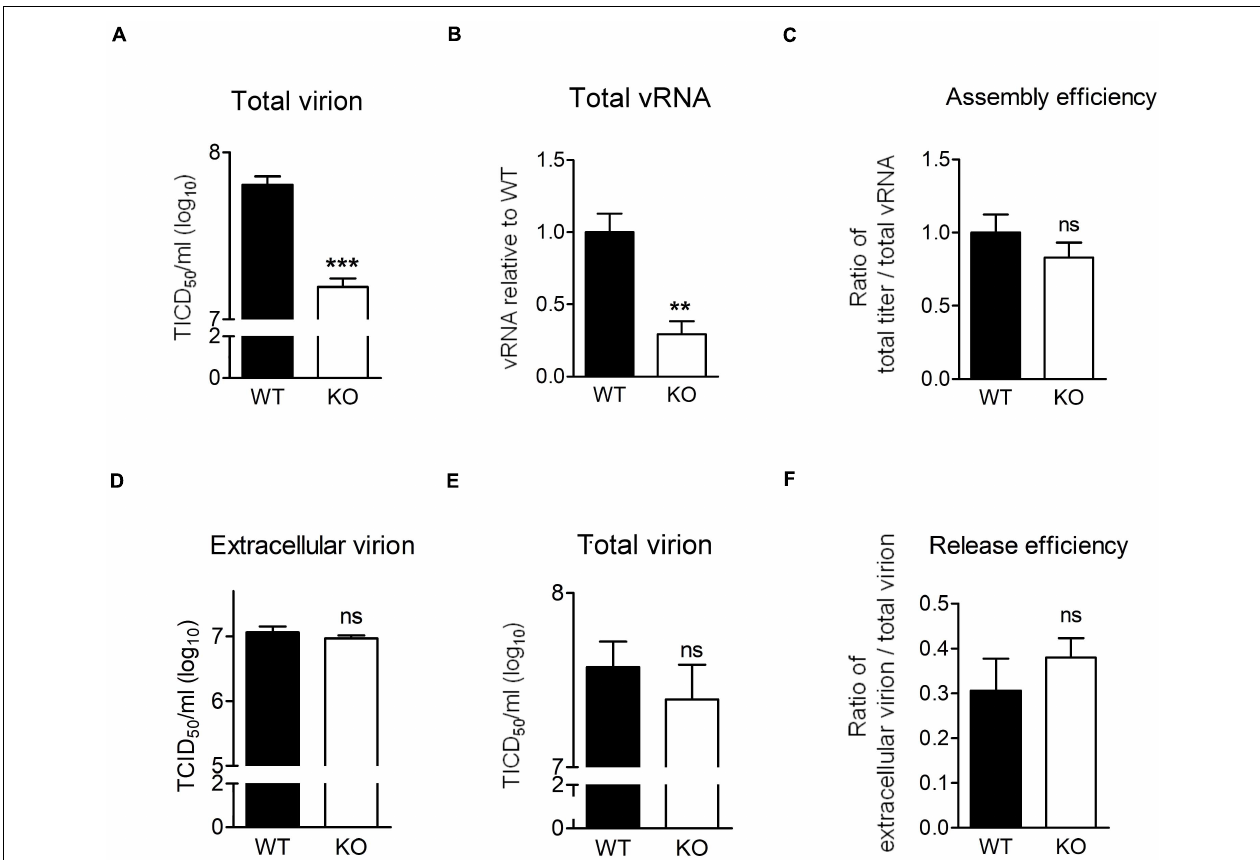
FIGURE 6 | HSPA6 depletion does not reduce virion assembly and release efficiency of EV-A71. (A–C) WT RD or HSPA6 KO RD cells were infected with EV-A71 (MOI = 5). At 9 hpi, (A) total virion and (B) total vRNA were prepared from the culture supernatant together with cell lysates for TCID 50 assay and RT-qPCR, respectively. (C) The assembly efficiencies, represented by the ratio of titer of total virion over total vRNA, are shown. (D–F) WT RD or HSPA6 KO RD cells were infected with EV-A71 (MOI = 5). At 12 hpi, (D) the extracellular virion from supernatant and (E) total virion were harvested and titrated using TCID 50 assay. (F) The release efficiencies, represented by the ratio of extracellular virion over total virion, are shown. The results were presented as means ± SD ( n = 3) and analyzed by unpaired Student’s t -test. *** P < 0.001, ** P < 0.01. ns, not